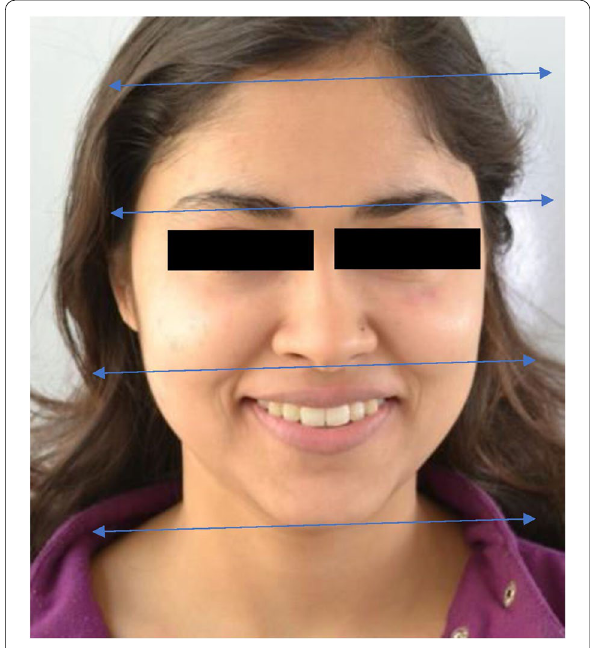
Fig. 7 Vertical proportions: hairline to eyebrows, eyebrow-base of nose, base of nose-chin should be equal for balanced face (Premkumar